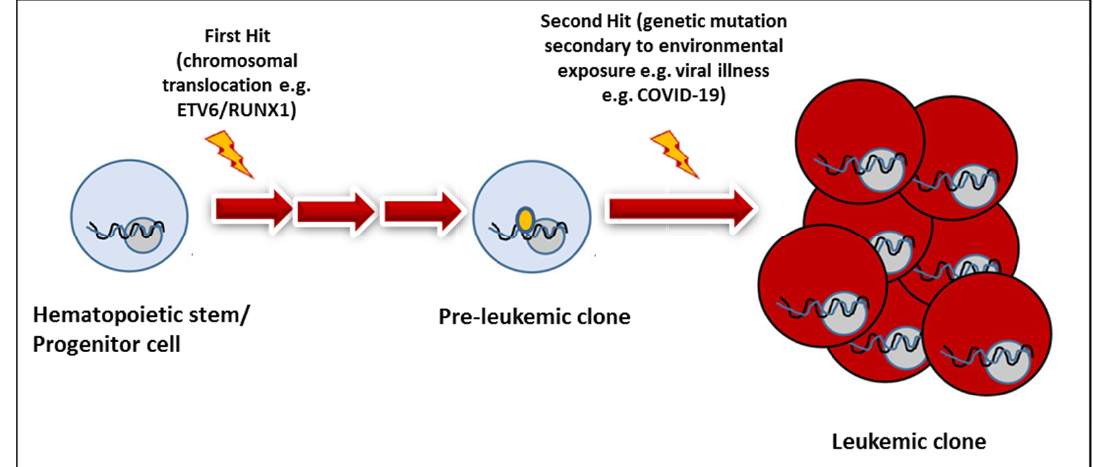
Figure 2. Demonstration of the two-hit hypothesis and COVID-19 can play a role in the second hit.